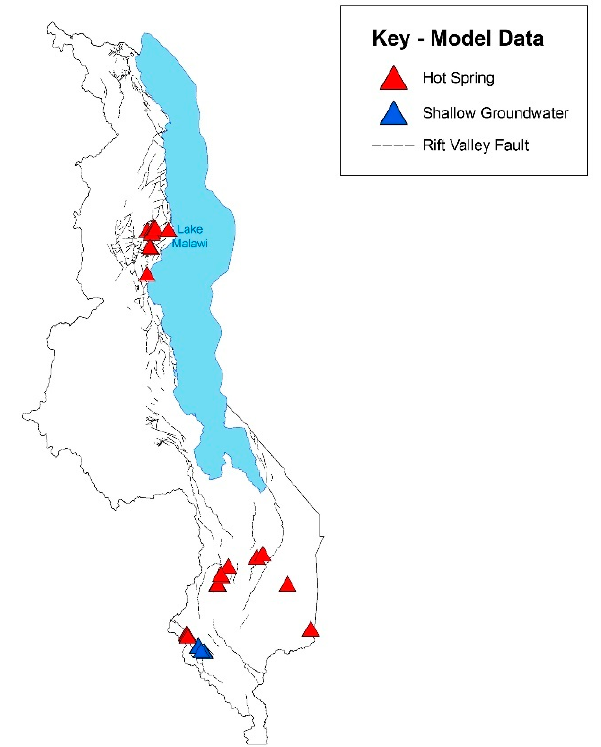
Figure 3. Map of Malawi showing locations of model hot spring and shallow groundwater data.